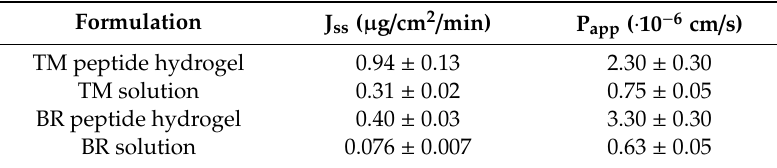
Figure 4. Ex vivo permeability profiles of ( A ). timolol maleate in ac-(RADA) 4 -CONH 2 peptide hydrogel and in PBS solution and of ( B ). brimonidine tartrate in ac-(RADA) 4 -CONH 2 peptide hydrogel and in PBS solution across porcine cornea ( n ≥ 4). Table 2. Apparent permeability and steady state flux values of TM and BR across porcine corneas. Data are expressed as mean ± standard deviation ( n ≥